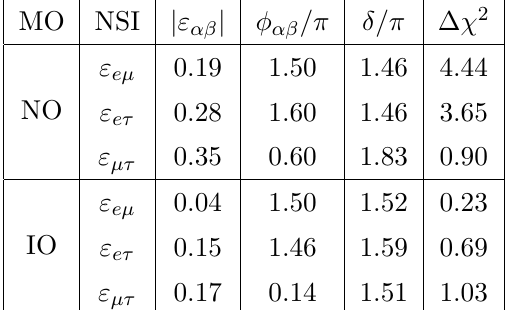
Table 6 . Best fit values to NOvA and T2K data and ∆ χ 2 = χ 2 one complex vector NSI parameter at a time. (For the SM, χ 2